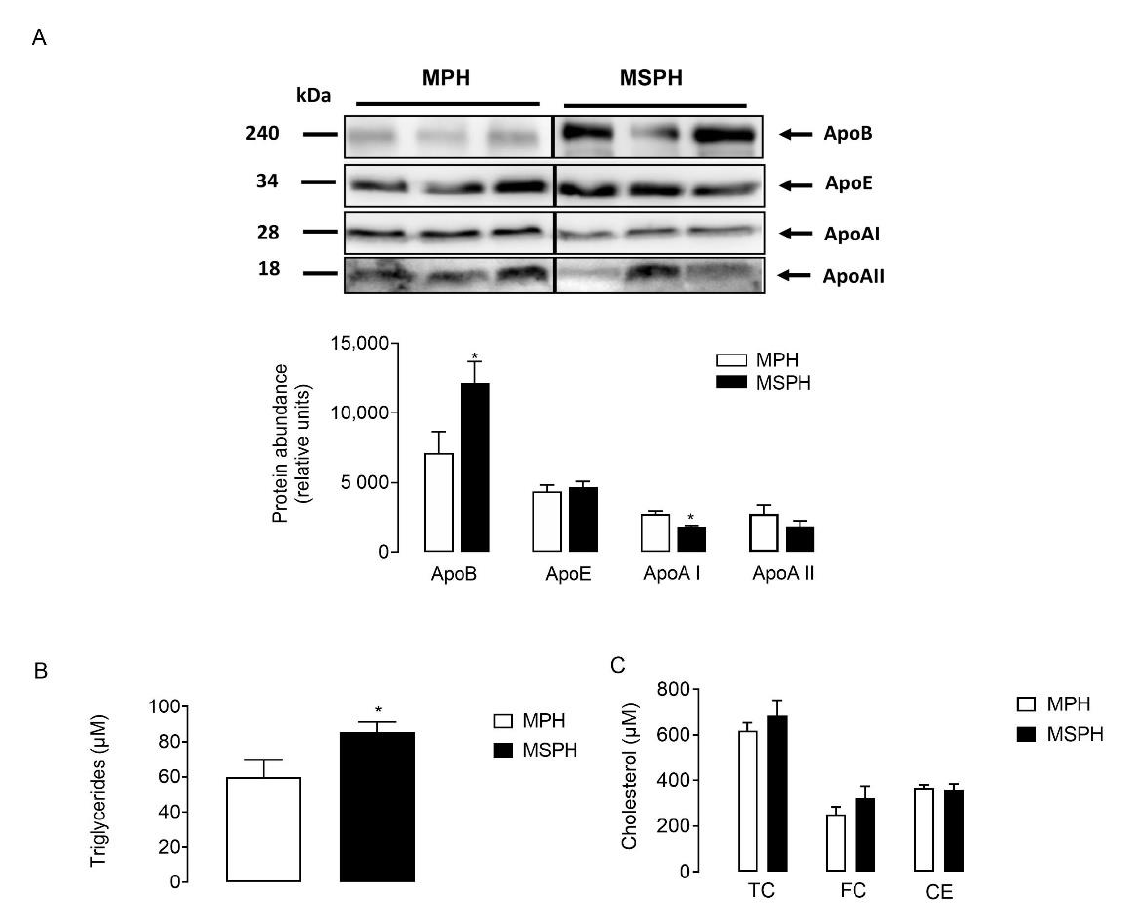
Figure 4. Composition of maternal LDL from MPH and MSPH women. ( A ) Representative Western blot showing the protein abundance of Apolipoprotein B (ApoB), AI (ApoAI) and E (ApoE), deter- mined in LDL isolated from MPH (white) and MSPH (black) maternal serum. Blot quantification is shown in the bar graph ( n = 7 per group). Equal quantities of proteins (30 ug) were loaded for each sample. ( B ) Triglycerides levels determined in LDL isolated from MPH (white) and MSPH (black) maternal serum. ( C ) Levels of cholesterol: total (TC), free (FC) and ester (CE) in LDL isolated from MPH (white) and MSPH (black) maternal serum. Values are mean ± S.E.M. * p < 0.05 versus values for MPH.